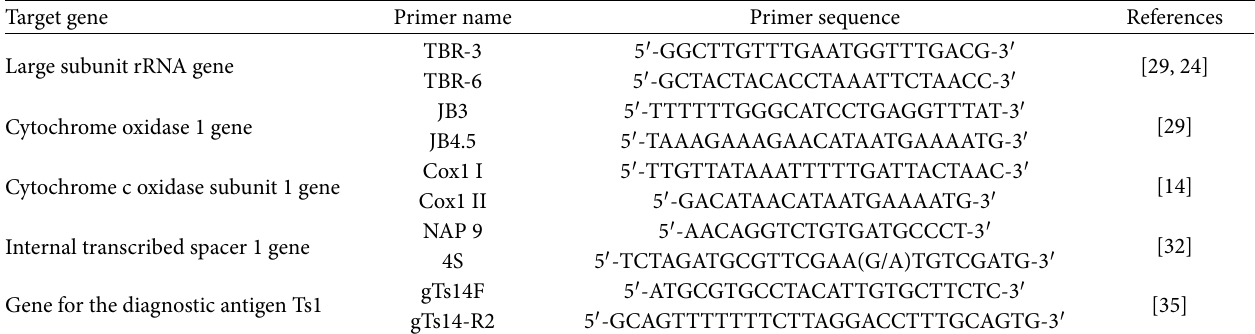
Table 2: Oligonucleotide primers used to detect Taenia solium by polymerase chain reaction.